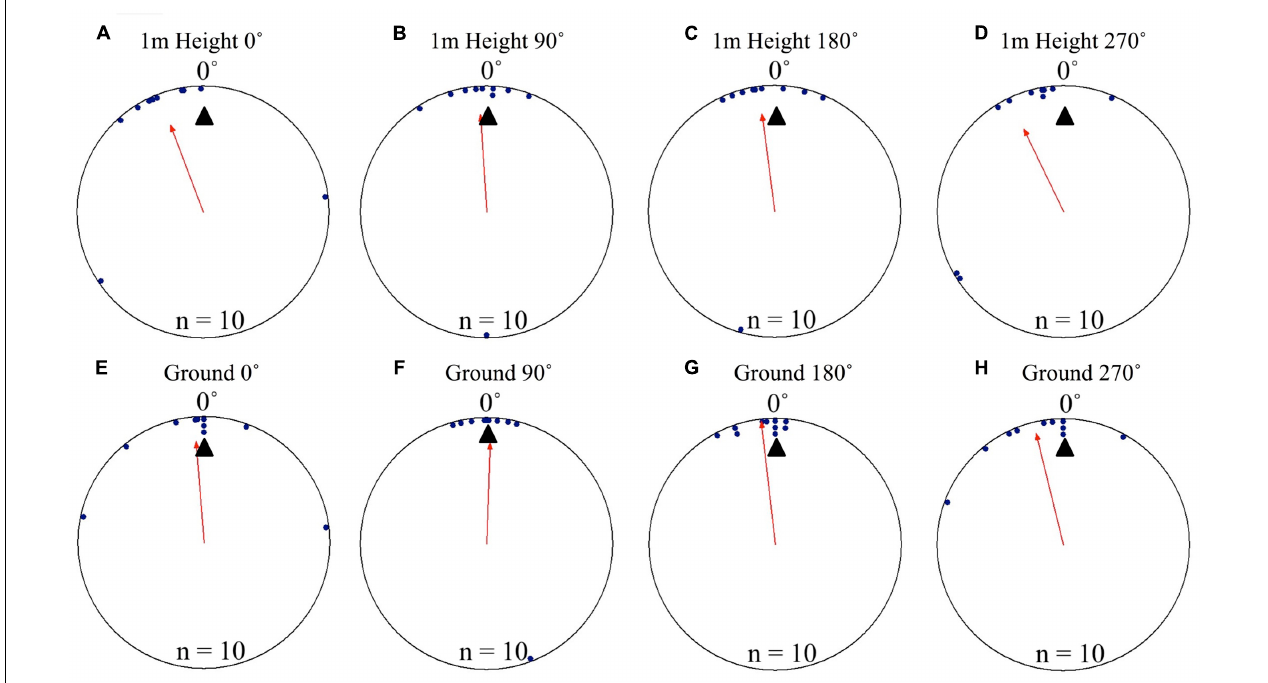
FIGURE 2 | Circular distributions of individual M. midas foragers’ positions on the tree face during displacement experiments on their foraging tree. Figures show the raw data of forager positions at two heights after displacements to one of four sides of the tree at a 2 m height at Nest 2. The nest direction for each figure is at 0 ◦ , labelled by a black triangle. The arrow denotes the direction and length of the mean vector. Foragers were collected at the base of their foraging tree, held overnight and then released vertically on the tree face at one of four sites (0, 90, 180, and 270 ◦ ). (A) The position of individual foragers released at the 0 ◦ location at 1 m in height. (B) Forager positions at Nest 2 of individuals released at the 90 ◦ location at 1 m in height. (C) Forager position at Nest 1 of individuals released at the 180 ◦ location at 1 m in height. (D) Forager positions at Nest 1 of individuals released at the 270 ◦ location at 1 m in height. (E) The position of individual foragers released at the 0 ◦ location as they reach the ground. (F) Forager positions of individuals released at the 90 ◦ location as they reach the ground. (G) The position of individual foragers released at the 180 ◦ location as they reach the ground. (H) Forager positions of individuals released at the 270 ◦ location as they reach the